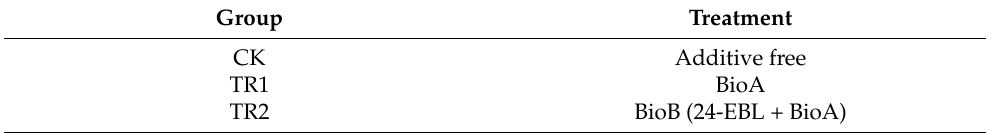
Table 3. Field treatment program. Group Treatment CK Additive free TR1